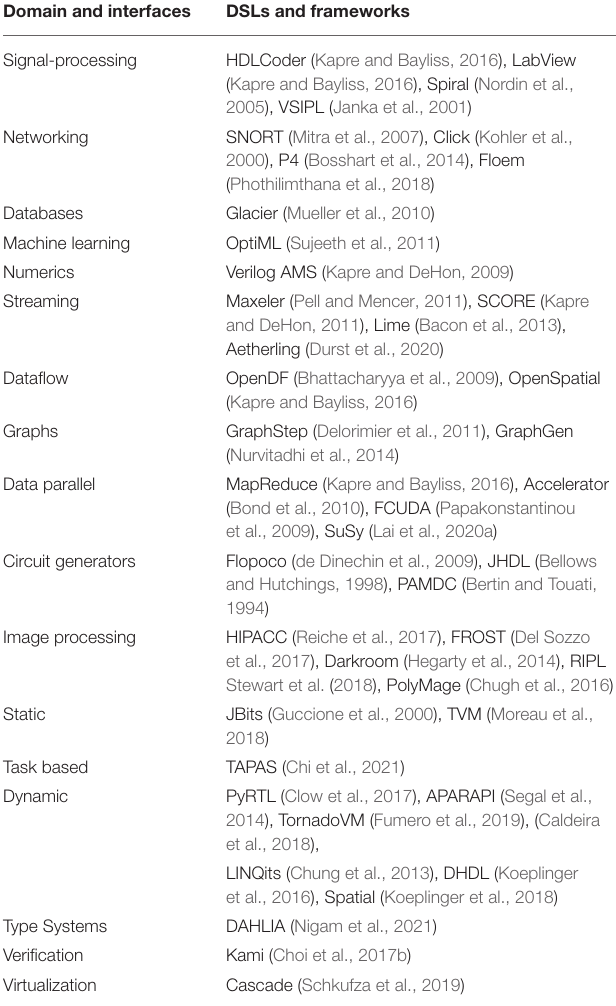
TABLE 5 | A brief taxonomy of domain-specific languages and frameworks for FPGA applications. Domain and